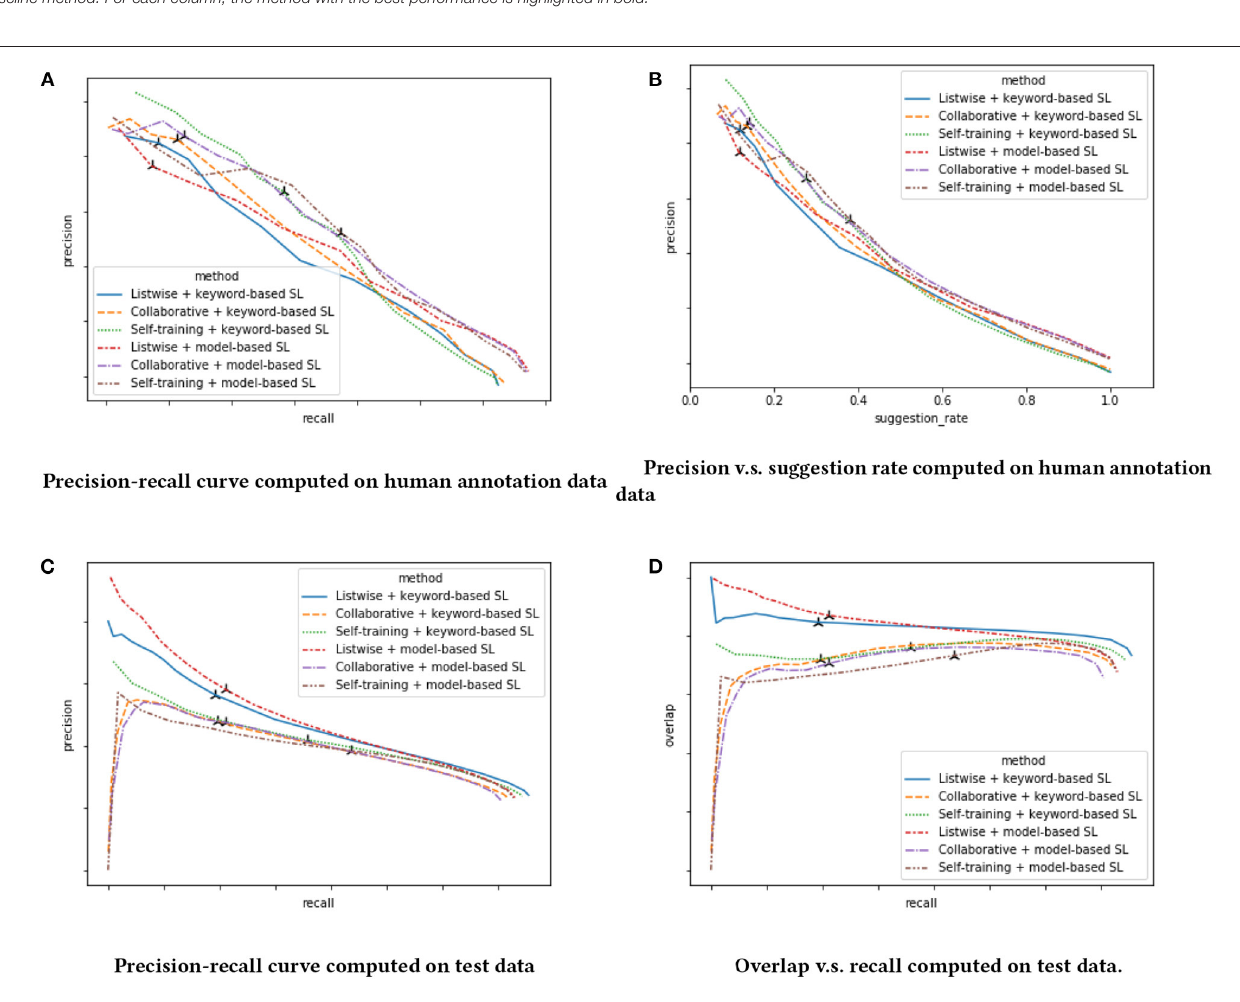
TABLE 2 | Summarization of two-stage recommender systems’ performance. Method